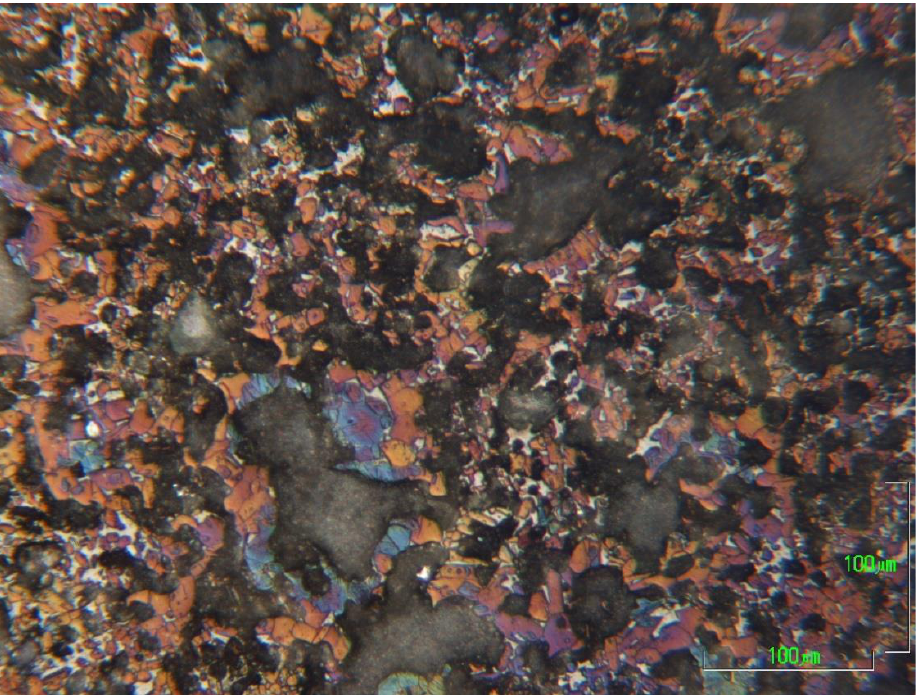
Figure 13. Image of optical microscopy of P 71A_1340 .